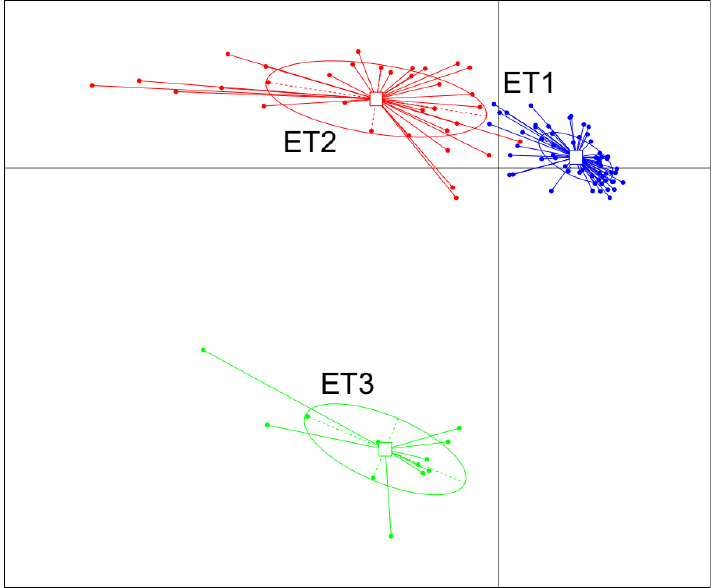
Figure 1. Enterotype clustering in a cohort of 105 experimental Jinhua pigs. The fecal samples were clustered into three distinct ETs using the JSD distance metric based on the relative abundances of bacteria at the genus level. Abbreviation: ET, enterotype.